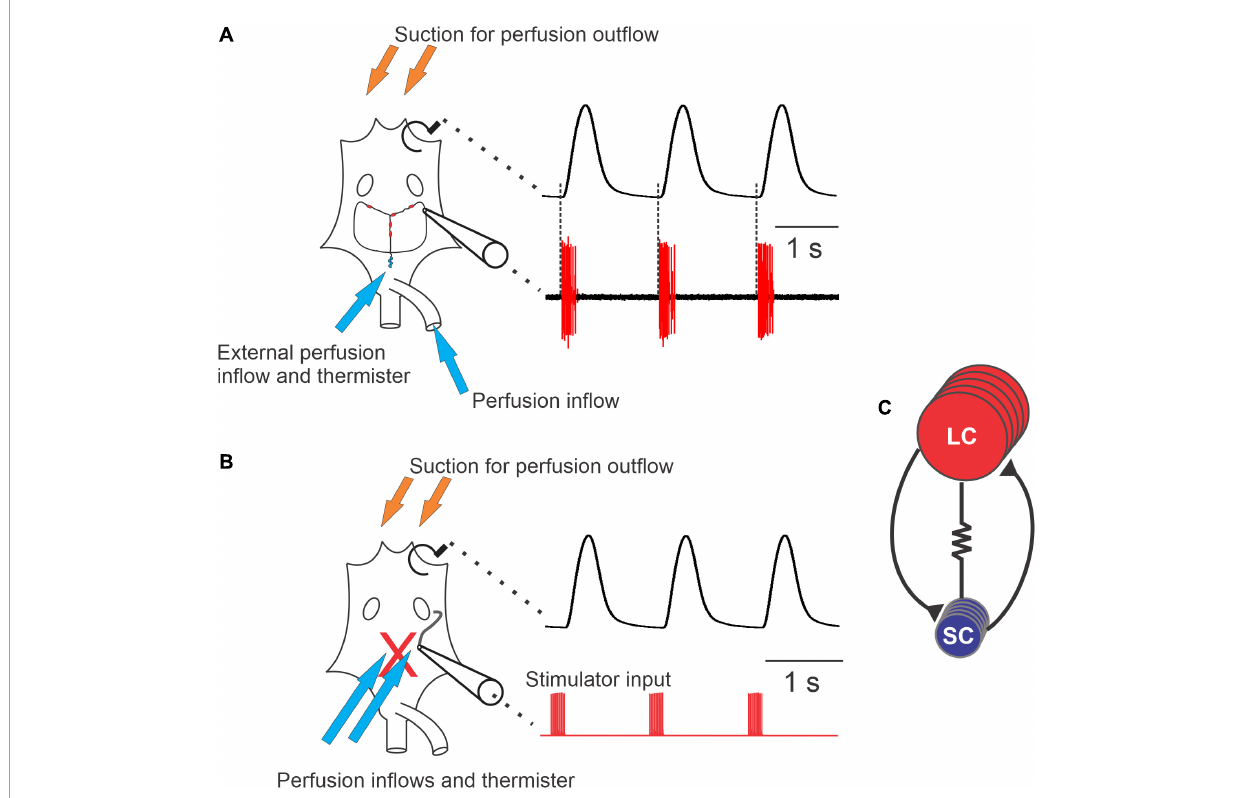
FIGURE1 Diagram of the cardiac neuromuscular system. (A) A schematic of a semi-intact preparation that allowed for simultaneous recordings of the force produced from each heartbeat (upper trace) and the neuron activity of the ganglion (lower trace). The cartoon of the heart (left) shows the relative location of the cardiac ganglion, location of the small cells (SCs, small blue circles) and the locations of the large cells (LCs, red ovals). Synaptic and axonal processes are depicted as black lines connecting the neurons. Large unfilled ovals show the relative location of the ventral ostia. Note that when comparing the timing of neuron action potential bursts and the heartbeat, each burst of action potentials precedes and corresponds to a contraction of the heart (dashed lines). (B) Schematic of a preparation in which the neurons have been removed from heart (replaced by the red “X”), leaving only a section of nerve intact (black tortuous line connected to the cartoon electrode) that can be stimulated. The traces to the right of the schematic show that the axons left in the motor nerve can be stimulated (red, lower trace) in order to generate fictive cardiac muscle contractions (black, upper trace). (C) Wiring diagram of the neurons in the CG, which contains five large cells (LCs) (red) and four small cells (SCs) (blue). While all neurons are electrically coupled, this cartoon only depicts coupling between neuron types (resistor symbol). Both large and small cells excite one another via chemical synapses (black lines terminating in black triangles). Arrows in panels (A,B) show approximate locations of perfusion inflows (blue) and outflows (orange), as well as the location of the thermistors used to measure temperature.